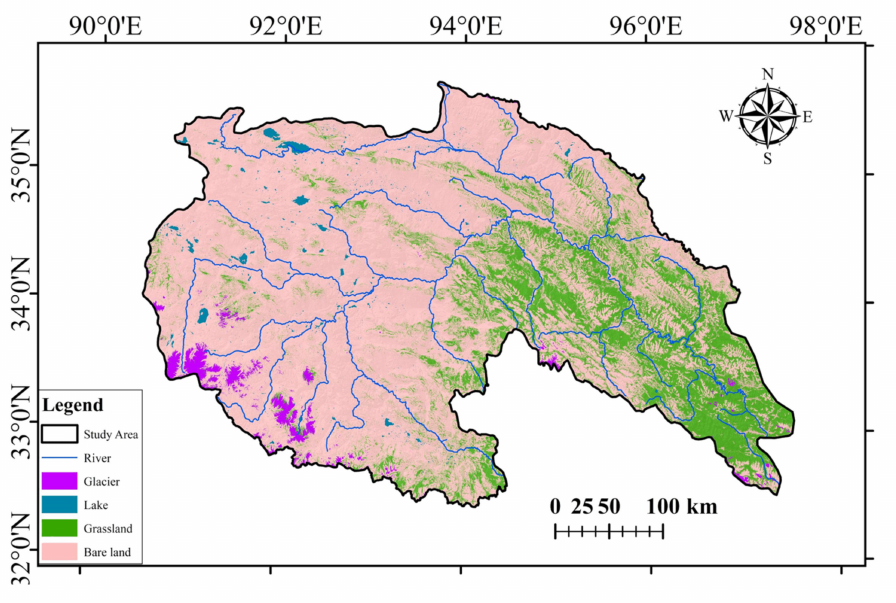
Figure 9. The spatial distribution of each eco-environment element in the initial